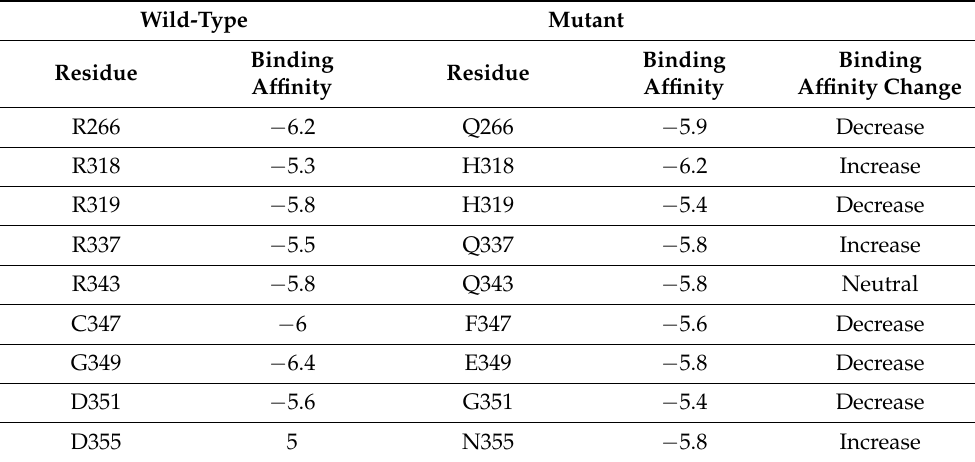
Table 4. Binding affinity of nine nsSNPs using molecular docking.